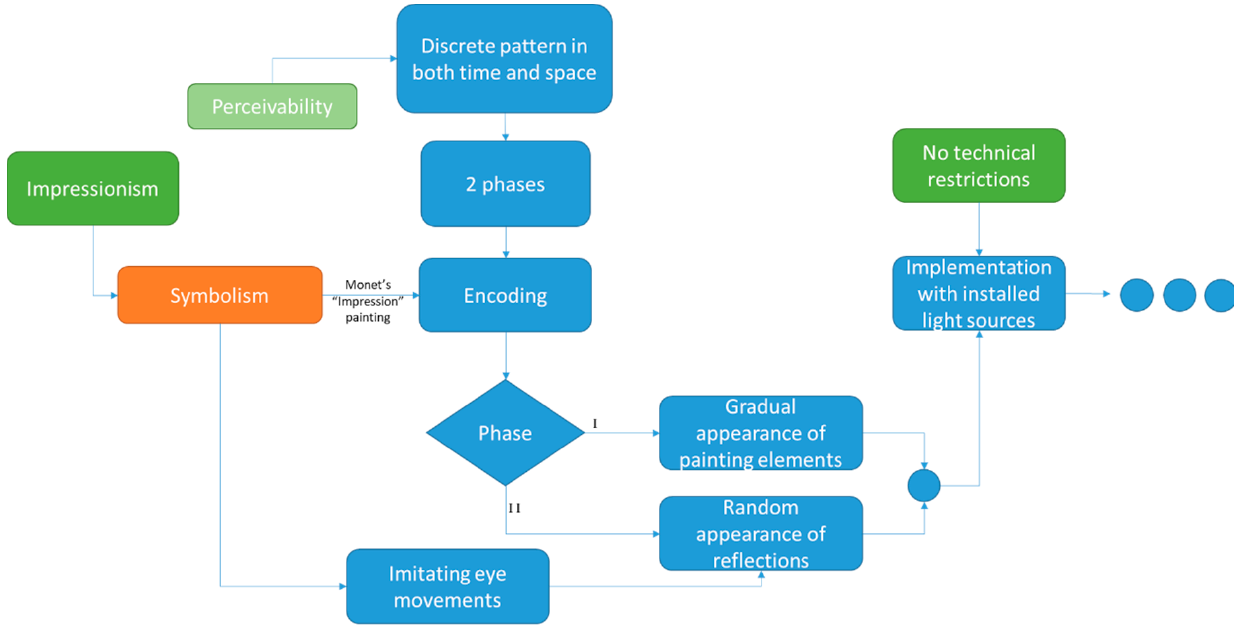
Figure 25. The working diagram for time variant lighting of historical building façade (tribute to impressionism). The end of the diagram has been deliberately omitted.